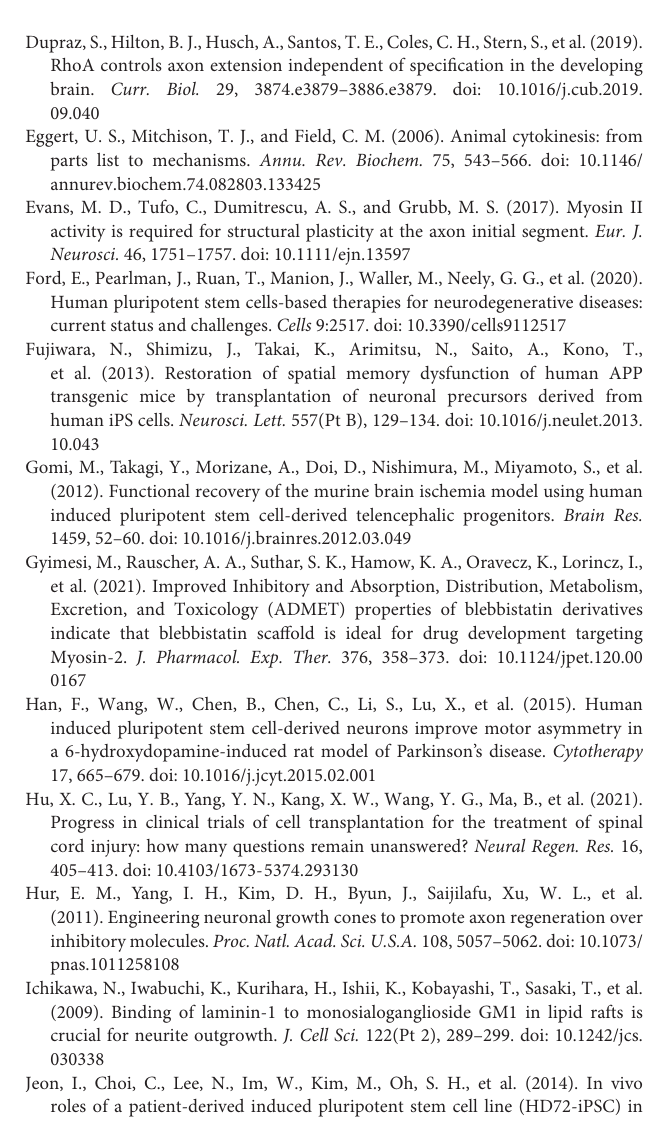
Supplementary Figure 2 | Assessing neurite outgrowth in NPCs expressing eGFP at a high level. (A) CAG promoter-driven eGFP sequence was inserted into Sleeping Beauty transposon vector, which also contained a puromycin resistance gene. The NPCs differentiated from pluripotent stem cells were co-transfected with this plasmid and another one harboring the sequence of the active transposase, resulting in insertion of the transgene into the genome of the NPCs. (B) After puromycin selection, the cells exhibited inhomogeneous eGFP expression levels (left panel). This cell culture was sorted for low and high (right panel) GFP-expressing populations. (C) GFP-expressing NPCs, seeded onto 96-well plates, were treated with various compounds. Six fields of view of each well were imaged in the indicated configuration. Image acquisition was performed for 4 h in 15-min intervals using a high-content screening equipment (ImageXpress Micro XLS, Molecular Devices). (D) During subsequent image analysis, on the basis of eGFP fluorescence and morphological parameters, the somas and neurites were identified at each timepoint using the Neurite Outgrowth module of MetaXpress software. Scale bars indicate 10 µ m. Supplementary Figure 3 | Effect of para-nitroblebbistatin on neurite outgrowth in hESC-derived NPCs. An experiment similar to that shown in Figure 2D with